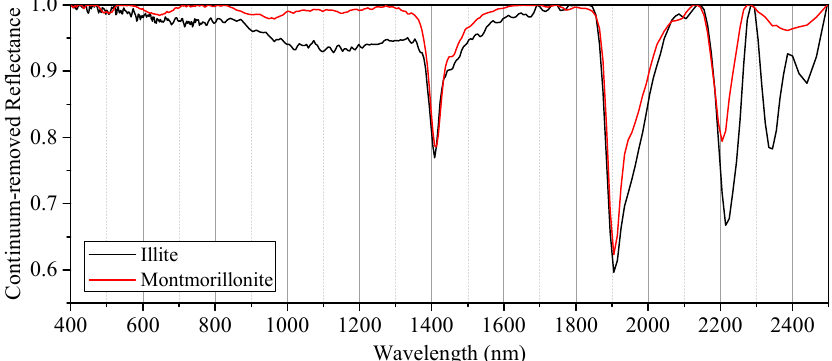
Figure 10. Continuum-removed spectra of illite and montmorillonite (USGS Mineral spectral library). These two clay minerals have absorptions near 1410, 1918, 2210 and two absorption shoulders near 1465 and 2095 nm.